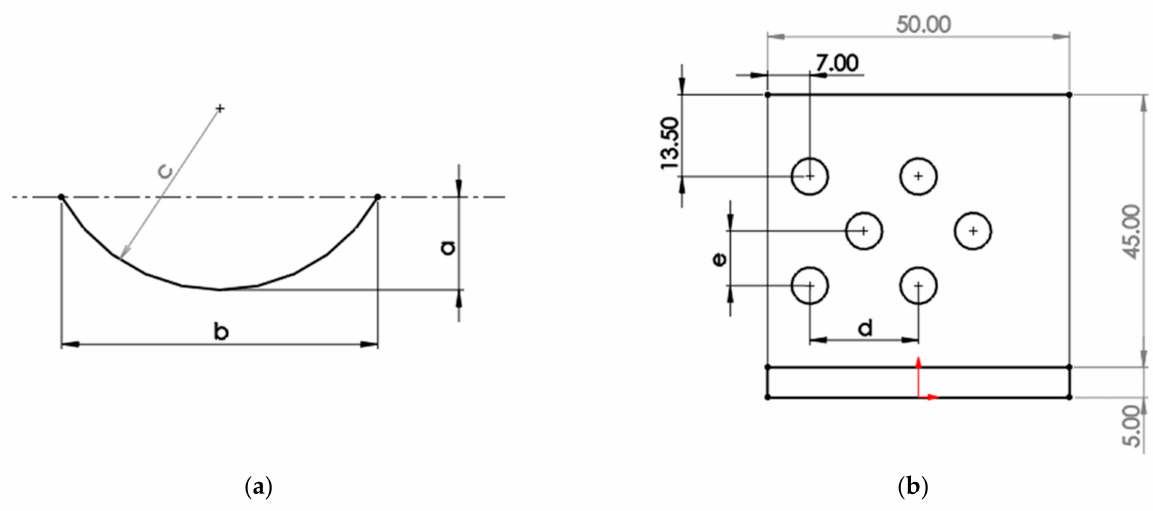
Figure 6. Geometrical dimensions for ( a ) dimple profile; ( b ) fin with dimples. Dimensions are in millimeters